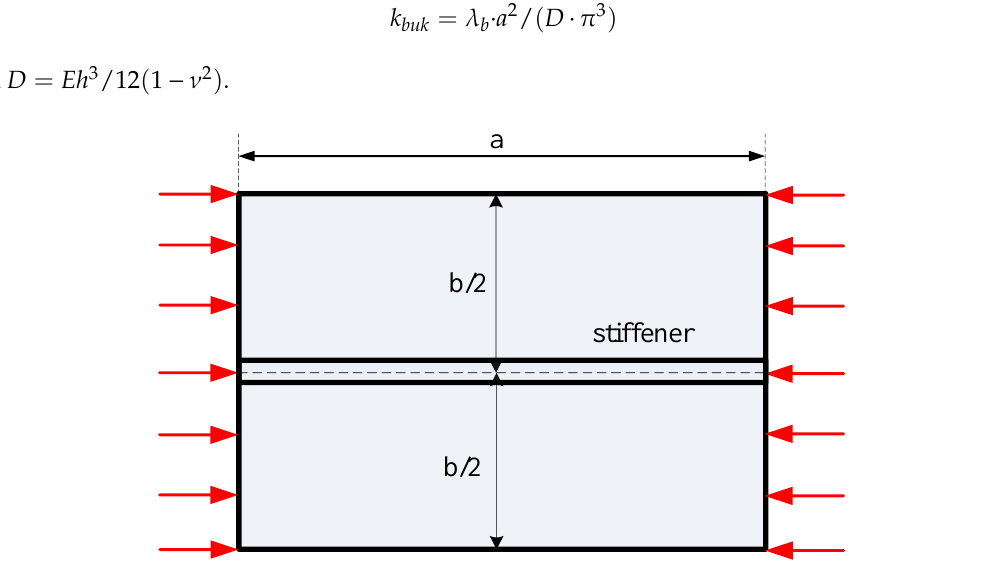
Figure 3. FGM plate with one central stiffener. Table 2. Buckling coe ffi cient of the clamped plate with a single sti ff